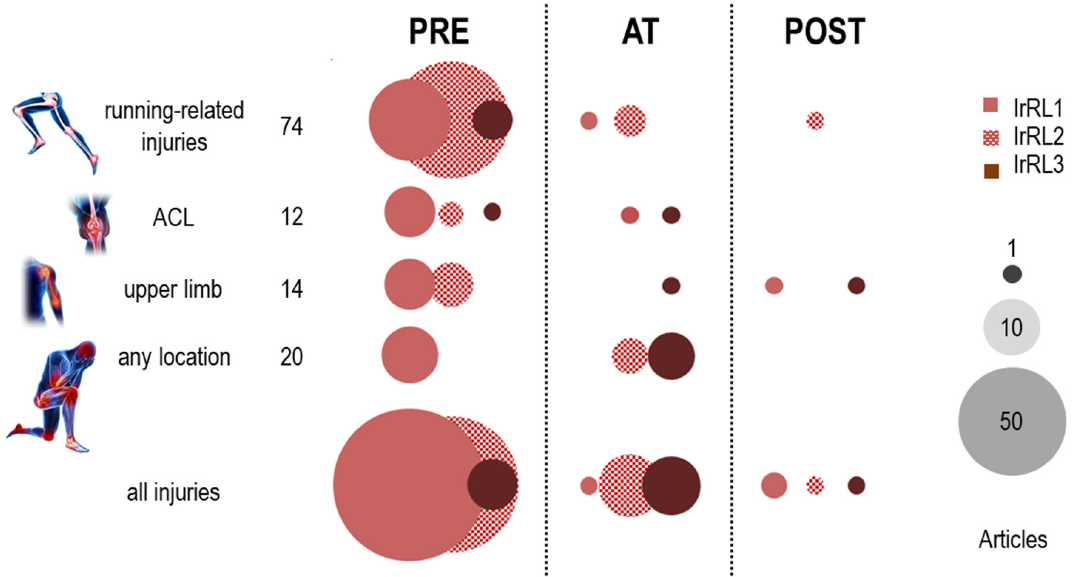
Figure 10. Distribution of studies at different injury-related readiness levels (IrRLs) for different time settings (columns) and injury types (rows).